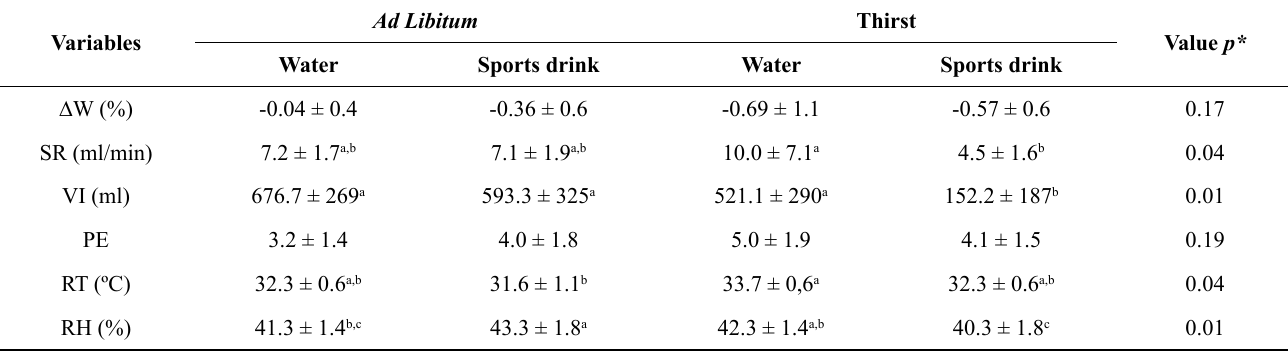
Table 1: Judokas’ hydration during training and the use of different beverages